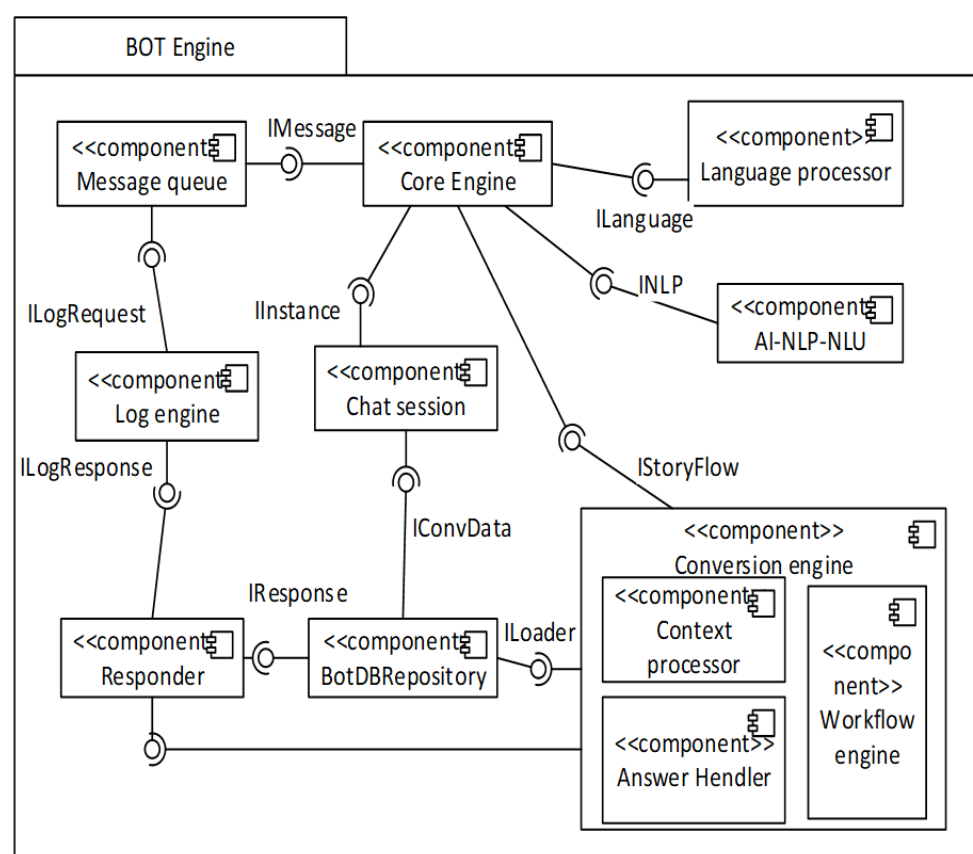
Figure 2. Bot engine component